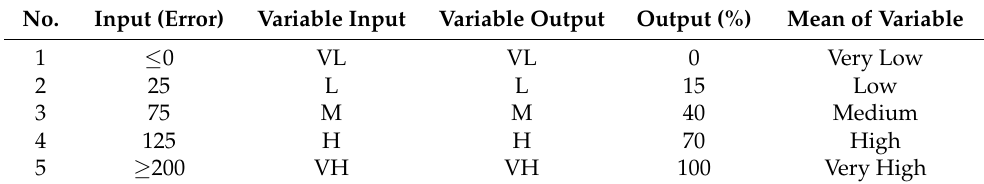
Figure 13. Membership function variables: ( a ) input variables; ( b ) output variables. Table 2. Input and output variables for fuzzy logic